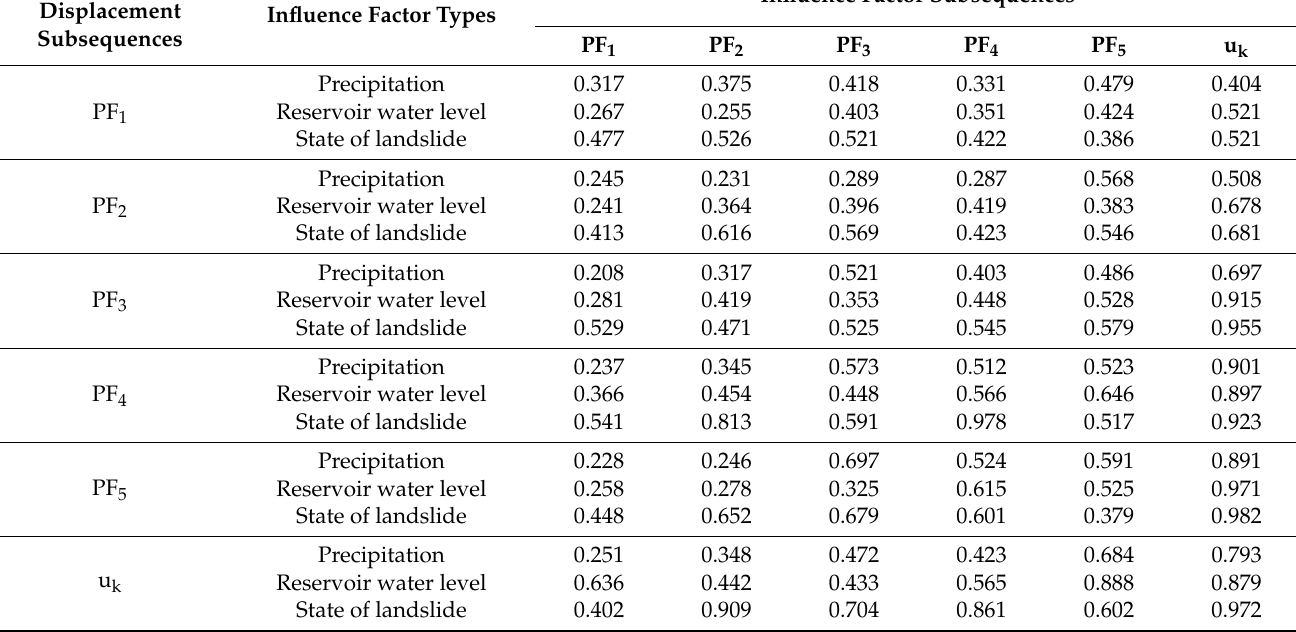
Table 1. MIC results for each landslide displacement subsequence with other